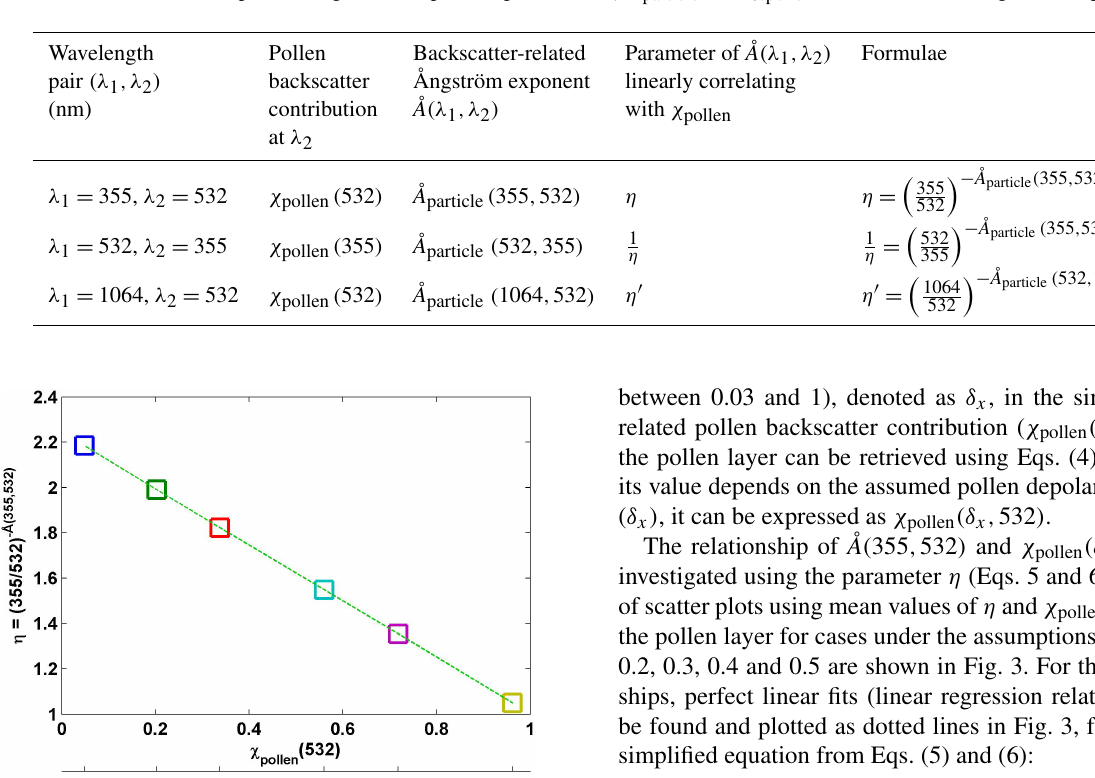
Table 2. The linear relationships resulting from the pairs of parameters η( Å particle ) and χ pollen at different wavelengths are reported.